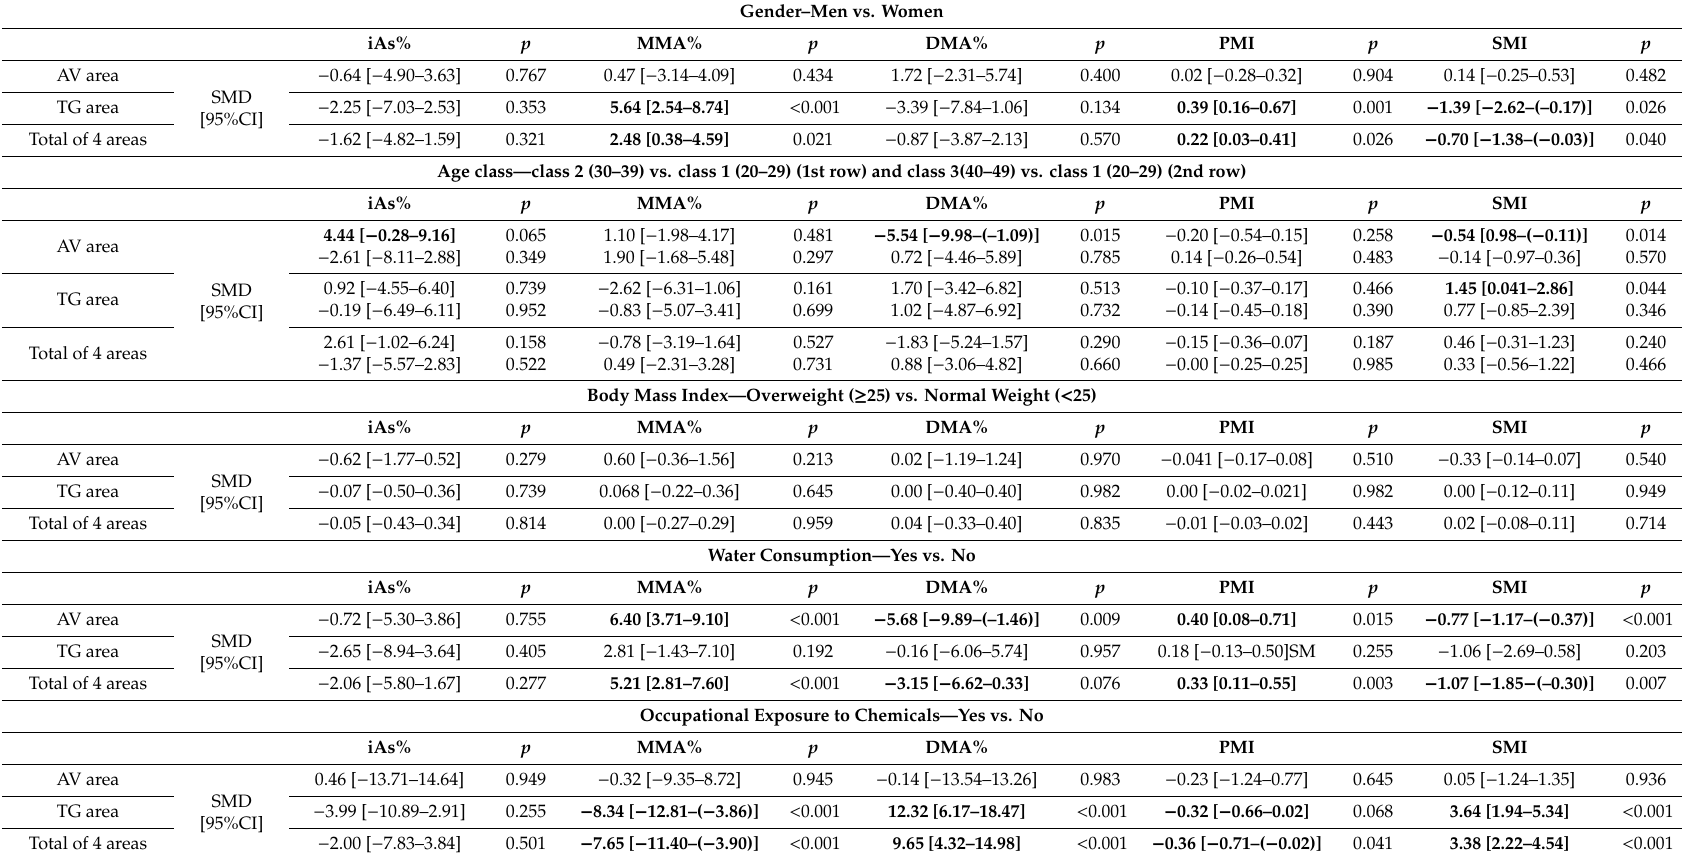
Table 3. E ff ects of factors analyzed on arsenic methylation considering the 4 areas as a whole and areas coupled by the origin of arsenic pollution, i.e. natural arsenic pollution (AV area) and anthropogenic arsenic pollution (TG area). Results are reported as Standardized Mean Di ff erences (SMDs) with the 95% Confidence Interval (95%CI) and the p -value for the arsenic methylation indexes, including the percentage of inorganic arsenic (iAs%), percentage of monomethyl arsenic (MMA%), percentage of dimethyl arsenic (DMA%), Primary Methylation Index (PMI) and Secondary Methylation Index (SMI). Gender–Men vs.